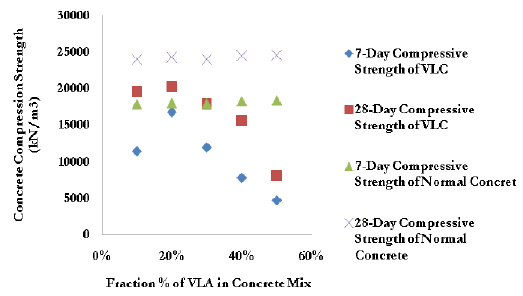
Fig.4. Compression Strength of Volcanic Concrete on 7